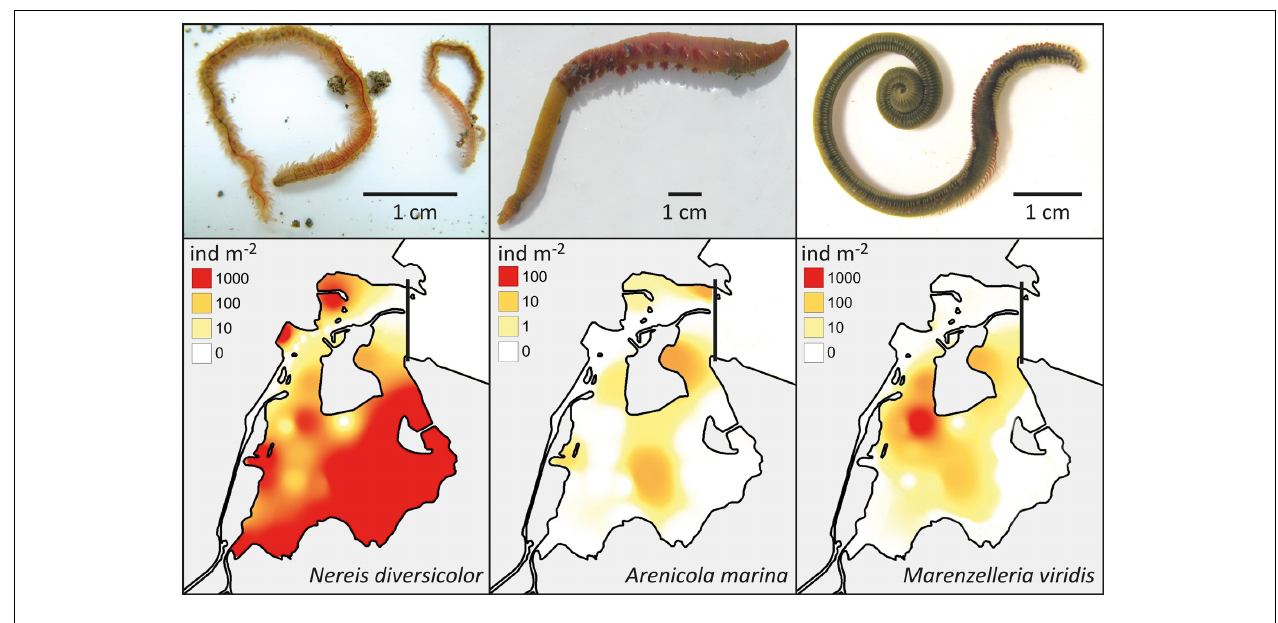
FIGURE 4 | Upper panel: The visual appearance of Nereis diversicolor , Arenicola marina and Marenzelleria viridis (Photos by E. Kristensen). Lower panel: The distribution and abundance of the